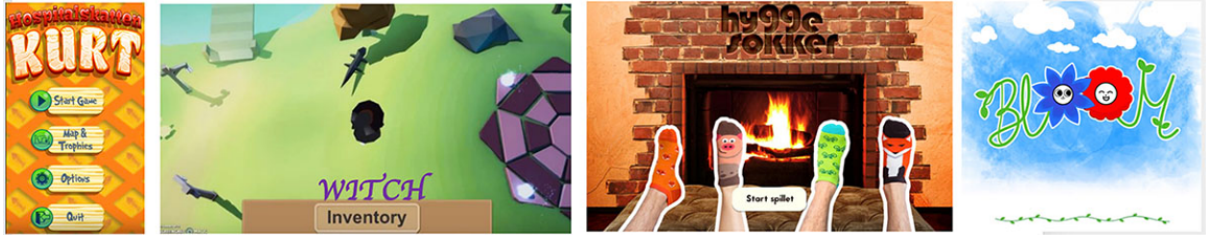
Figure 1. Front pages for game